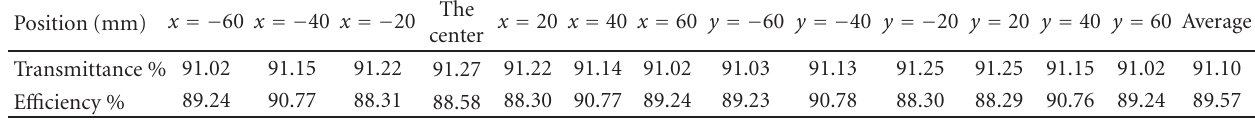
Table 1: The local transmittance and concentration e ffi ciency of concentration system through software simulation.